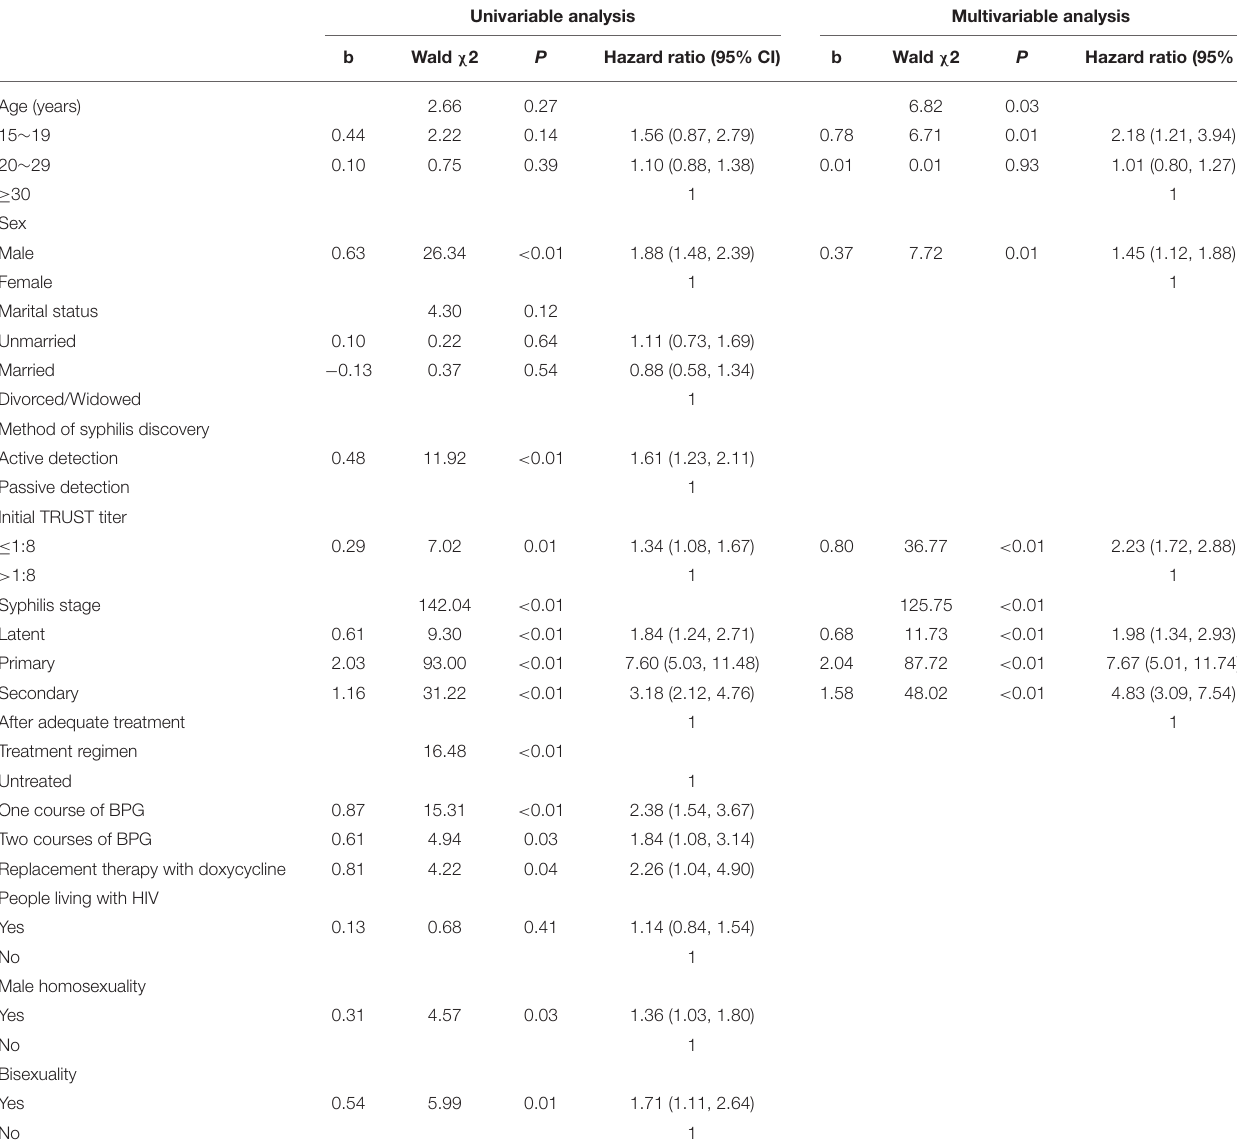
TABLE 2 | Results of univariable and multivariable analyses of factors associated with TRUST seronegative conversion among syphilis patients. Univariable analysis Multivariable